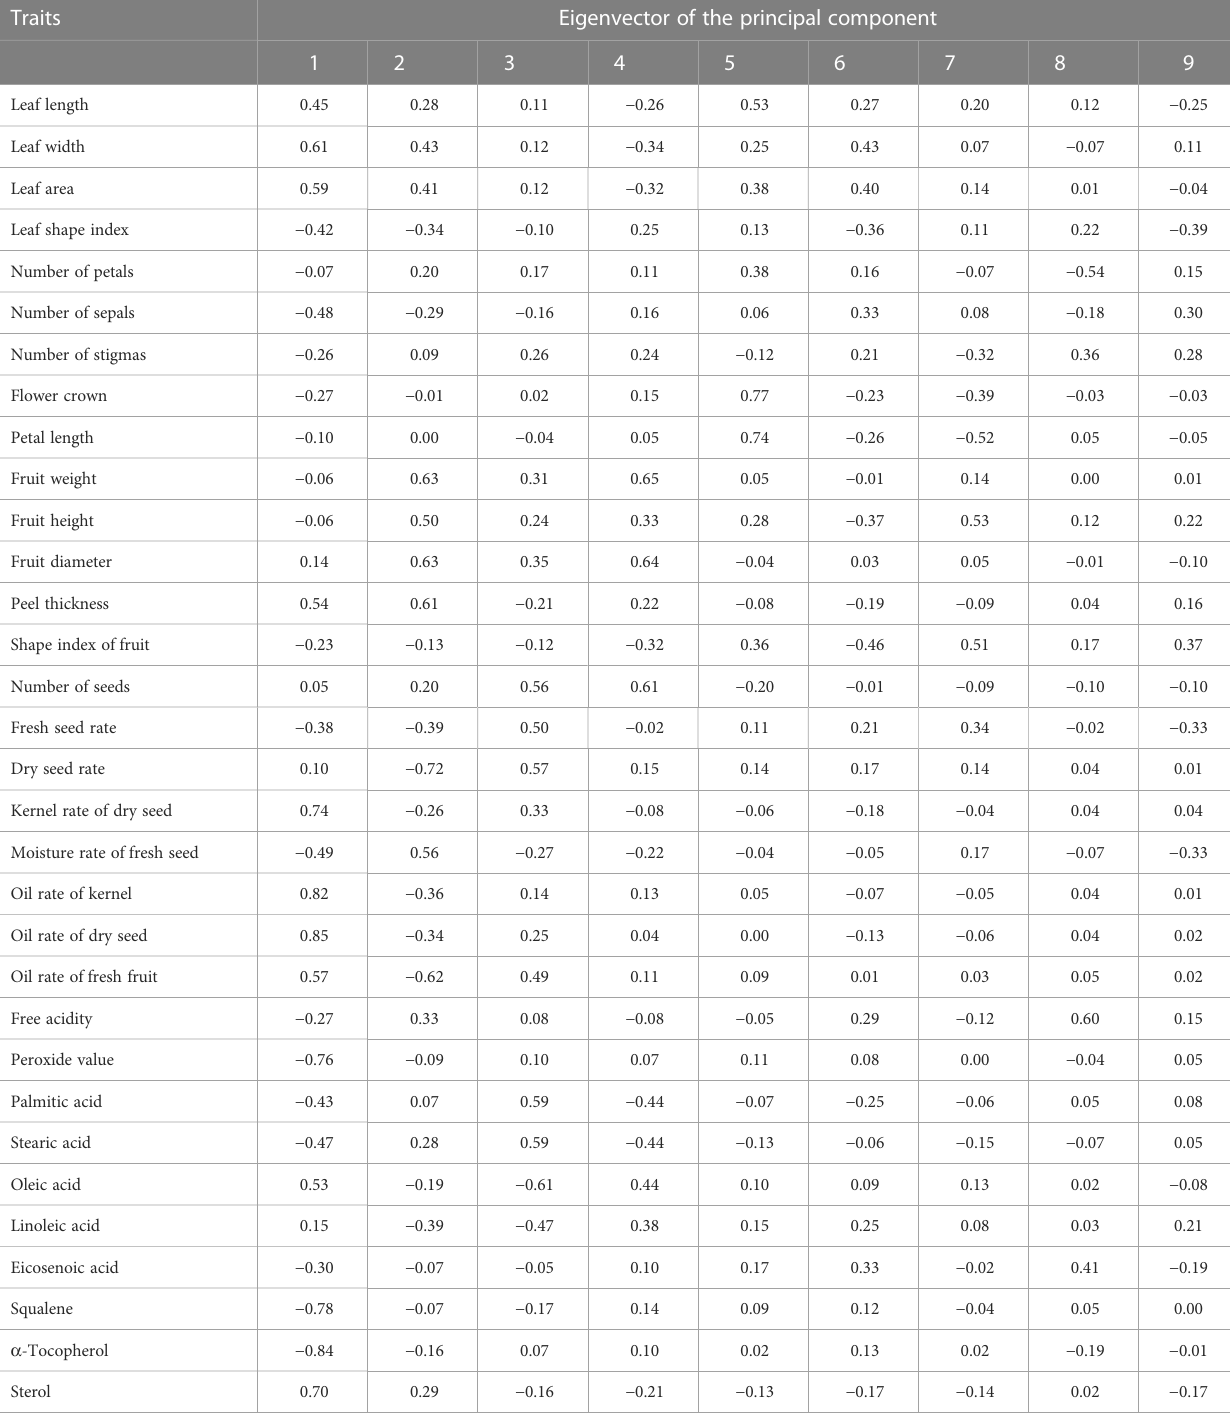
TABLE 4 The principal component analysis of the 32 quantitative characters in the 143 wild C. oleifera accessions. Traits Eigenvector of the principal